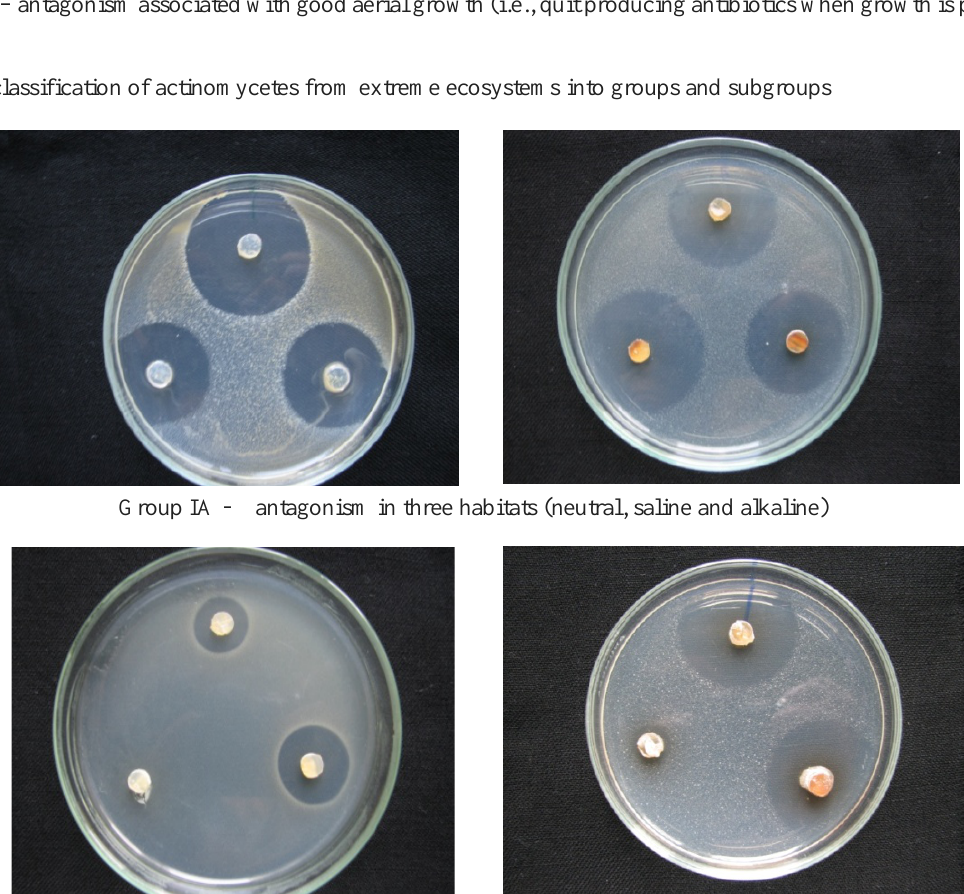
Subgroup IBа - antagonism in neutral and saline